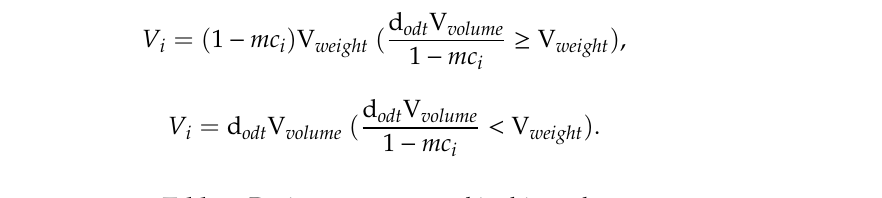
Table 1. Drying types assumed in this